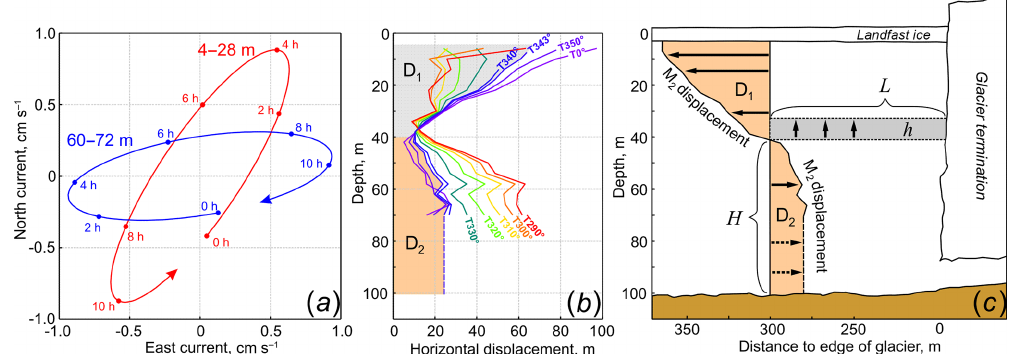
Figure 10. (a) The mean lunar semidiurnal (M 2 ) tidal ellipses in the surface (6–26m, red) and intermediate (62–70m, blue) layers. Arrows show the rotation direction and dots indicate every 2h interval. (b) The absolute horizontal displacements of water parcels through the water column within a half M 2 tidal cycle ( ∼ 6.21h) for different projections are shown with colour lines (the numbers correspond to the projection angle from the north). The coloured numbers indicate the projection angles. The shaded areas (D 1 and D 2 ; where D 1 = D 2 ) correspond to the total tidal transport in the surface (4–40m) and bottom (40–101m) layers projected at T343 ◦ . (c) The mechanism of the tidal internal wave generation at the glacier terminus associated with the divergence of the baroclinic M 2